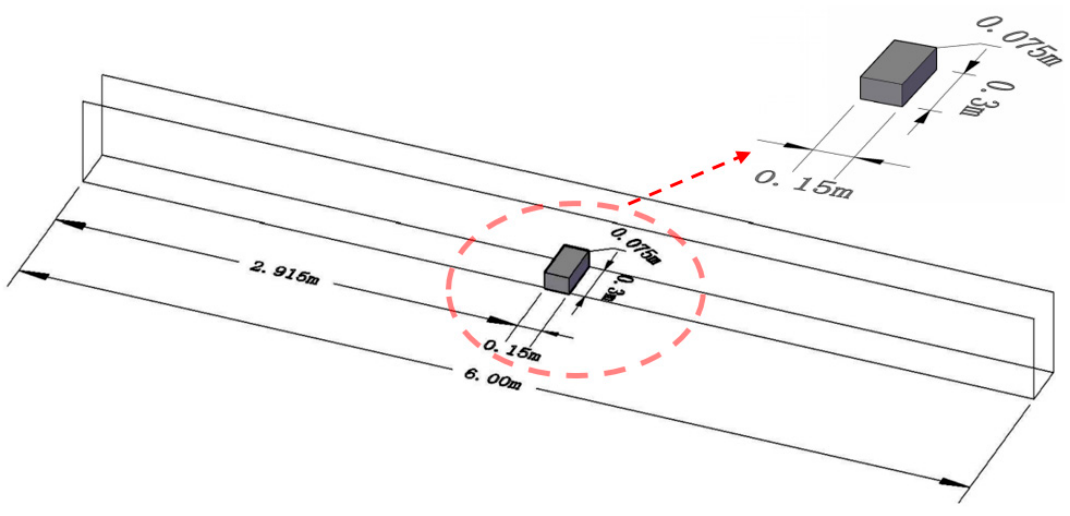
Figure 4. Schematic diagram of the numerical water tank.